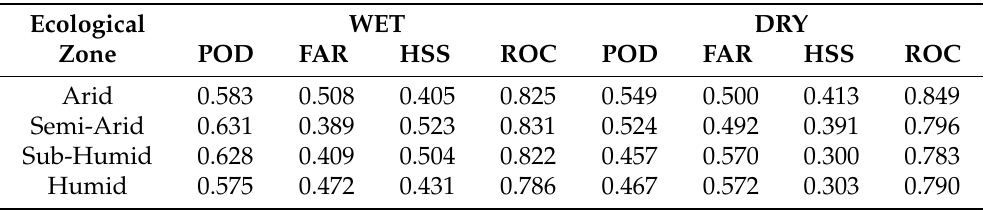
Figure 8. This image shows the ROC for wet anomaly events. Table 2 shows the average skill for each ecological zone. For dry anomaly events, forecasts for the sub-humid and semi-arid zones performed well. For wet anomaly events, forecasts for arid and semi-arid zones performed the best, while all other zones per- formed similarly. Table 2. This table shows the average skill over each ecological zone for a 3 month lead